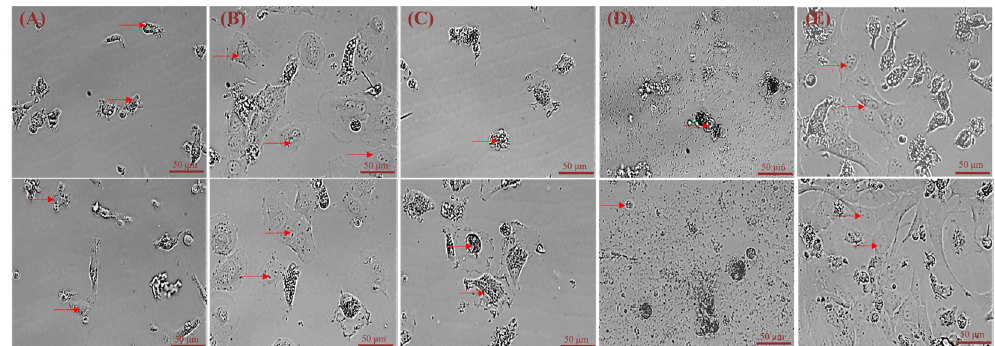
Figure 2. Morphological characteristics of primary sheep hepatocytes isolated using five different methods (brightfield imaging). ( A ) Liver tissue cut into 1 mm 3 pieces; ( B ) Cut tissues treated subjected to 1 mg/mL type IV collagenase digestion; ( C ) Cut tissues treated subjected to 0.1 mg/mL type IV collagenase digestion; ( D ) Cut tissues treated subjected to 0.25% trypsin digestion; ( E ) Cut tissues treated subjected to digestion using a 1:1 0.25% trypsin +0.1 mg/mL type IV collagenase mix. The above image shows 4 days of culturing; the below image shows 6 days of culturing. Note: red arrows indicate primary hepatocytes.